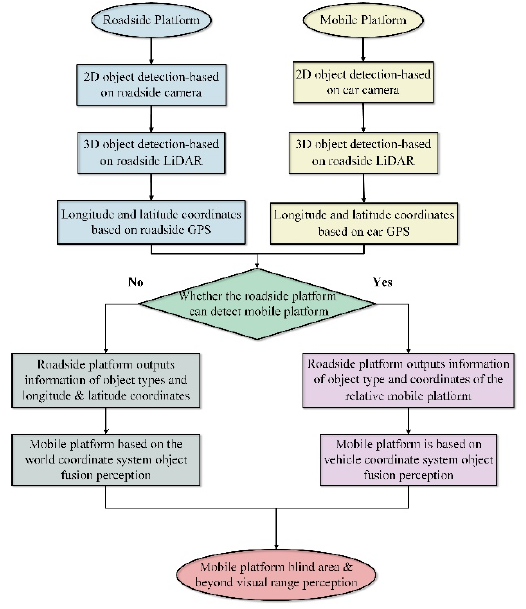
Figure 5. Flowchart of the road–vehicle collaborative perception technique.